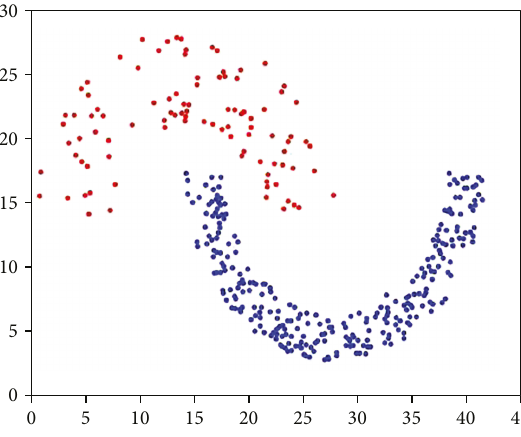
Figure 11: The distribution of JAIN.